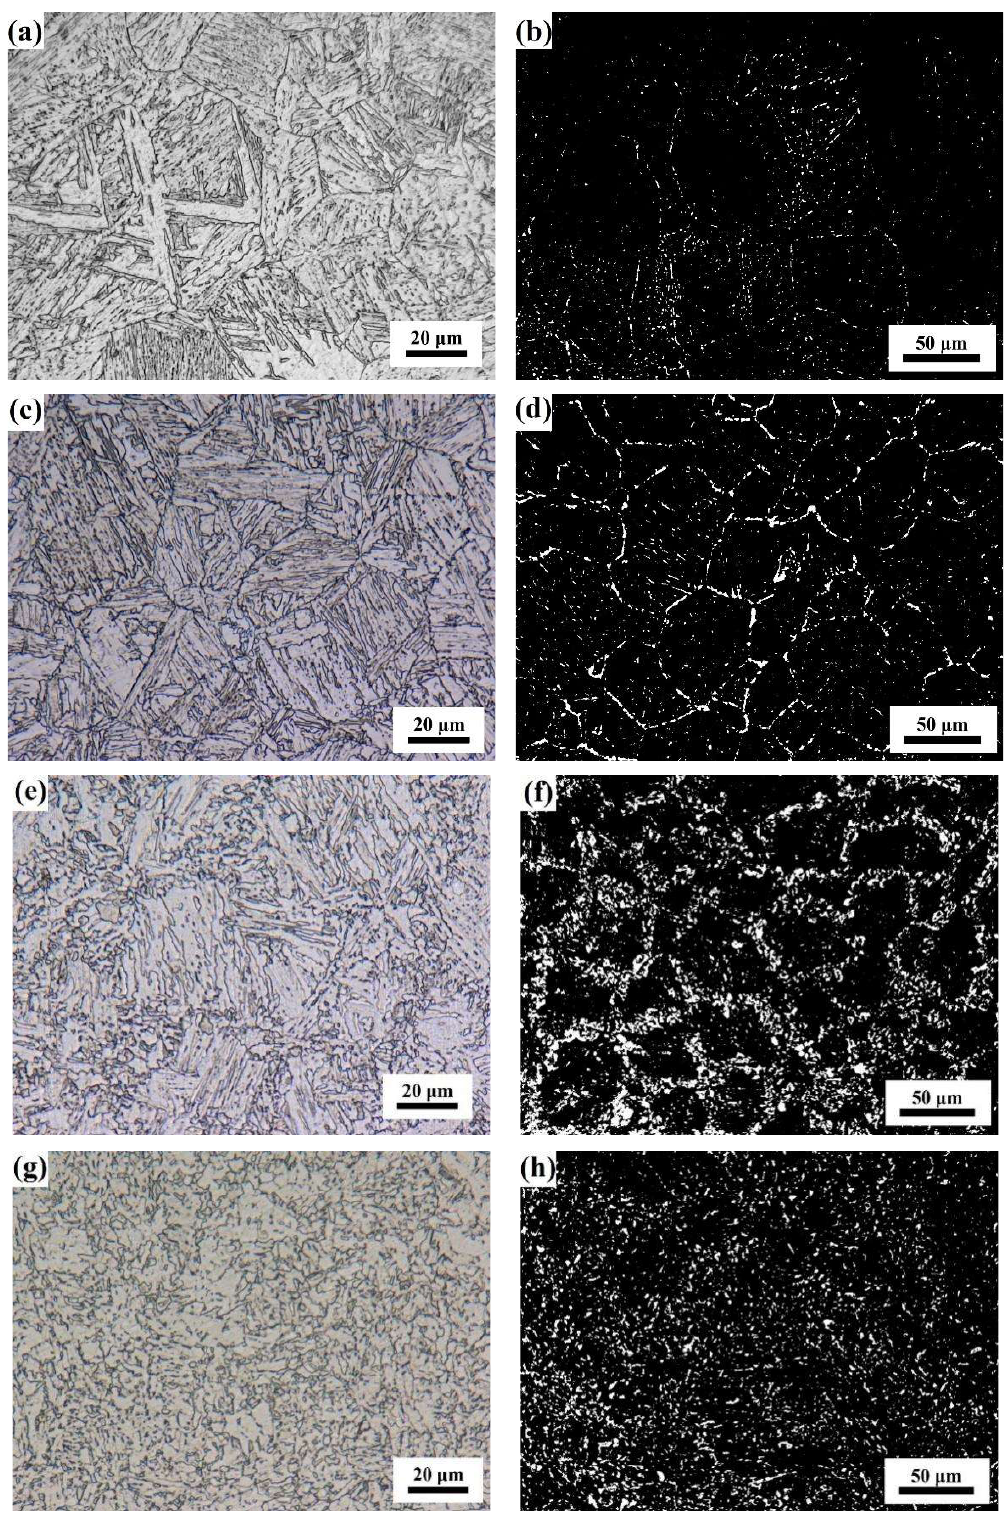
Figure 3. Microstructure and M/A constituents of the simulated CGHAZ and ICCGHAZs with different secondary peak temperatures: ( a , b ) CGHAZ; ( c , d ) ICCGHAZ-1; ( e , f ) ICCGHAZ-2; ( g , h ) ICCGHAZ-3.